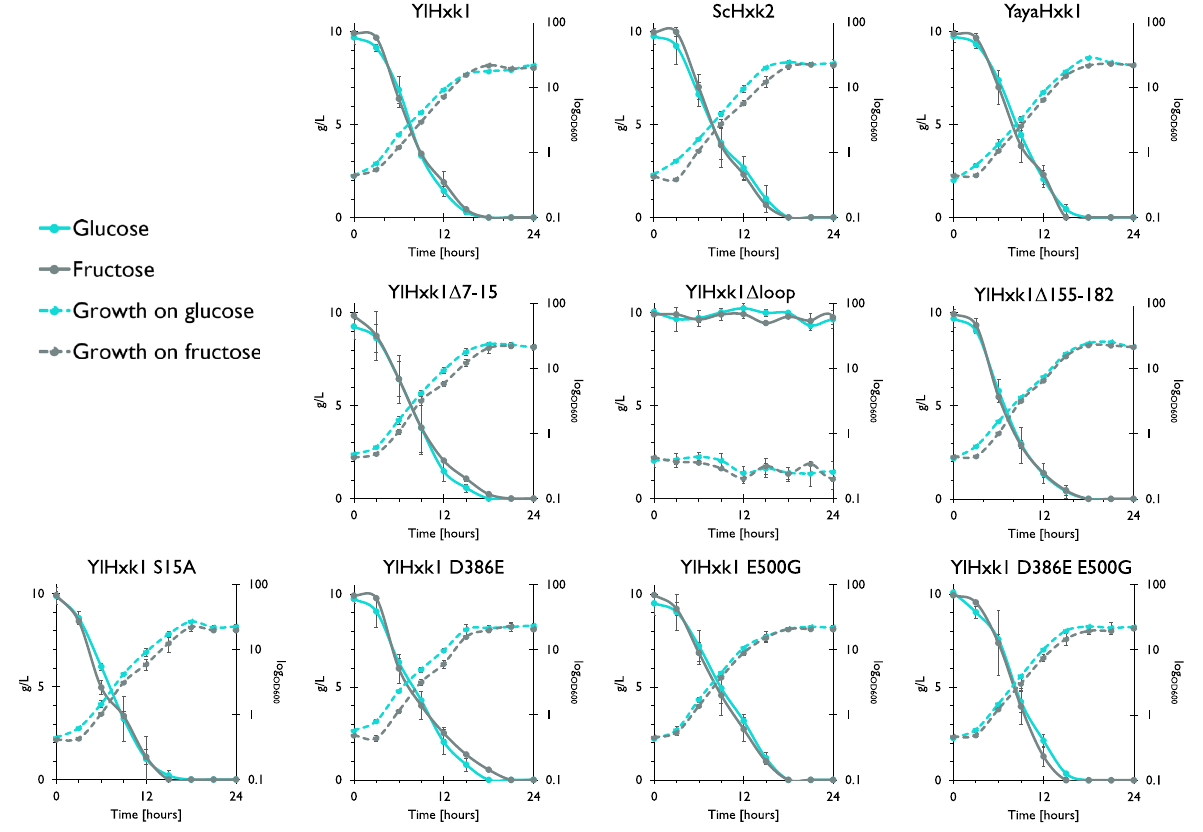
Figure 3. Growth and substrate utilization of Y. lipolytica strains expressing different hexokinase variants in YNB minimal medium with glucose or